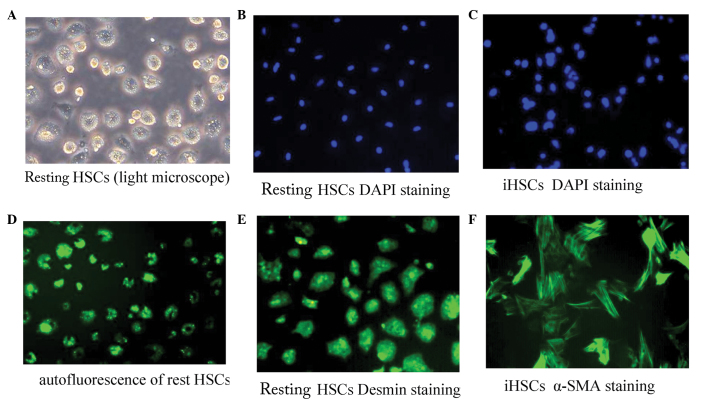
(A) Refraction of lipid droplets in resting HSCs observed under light microscopy. (B) DAPI staining of nuclei in resting HSCs. (C) DAPI staining of iHSC nuclei. (D) Blue-green fluorescence in resting HSCs following excitation at 328 nm. (E) Desmin staining demonstrated the purity of HSCs was >95%. (F) α-SMA positive iHSCs. HSCs, hepatic stellate cells; iHSCs, induction-activated HSCs.